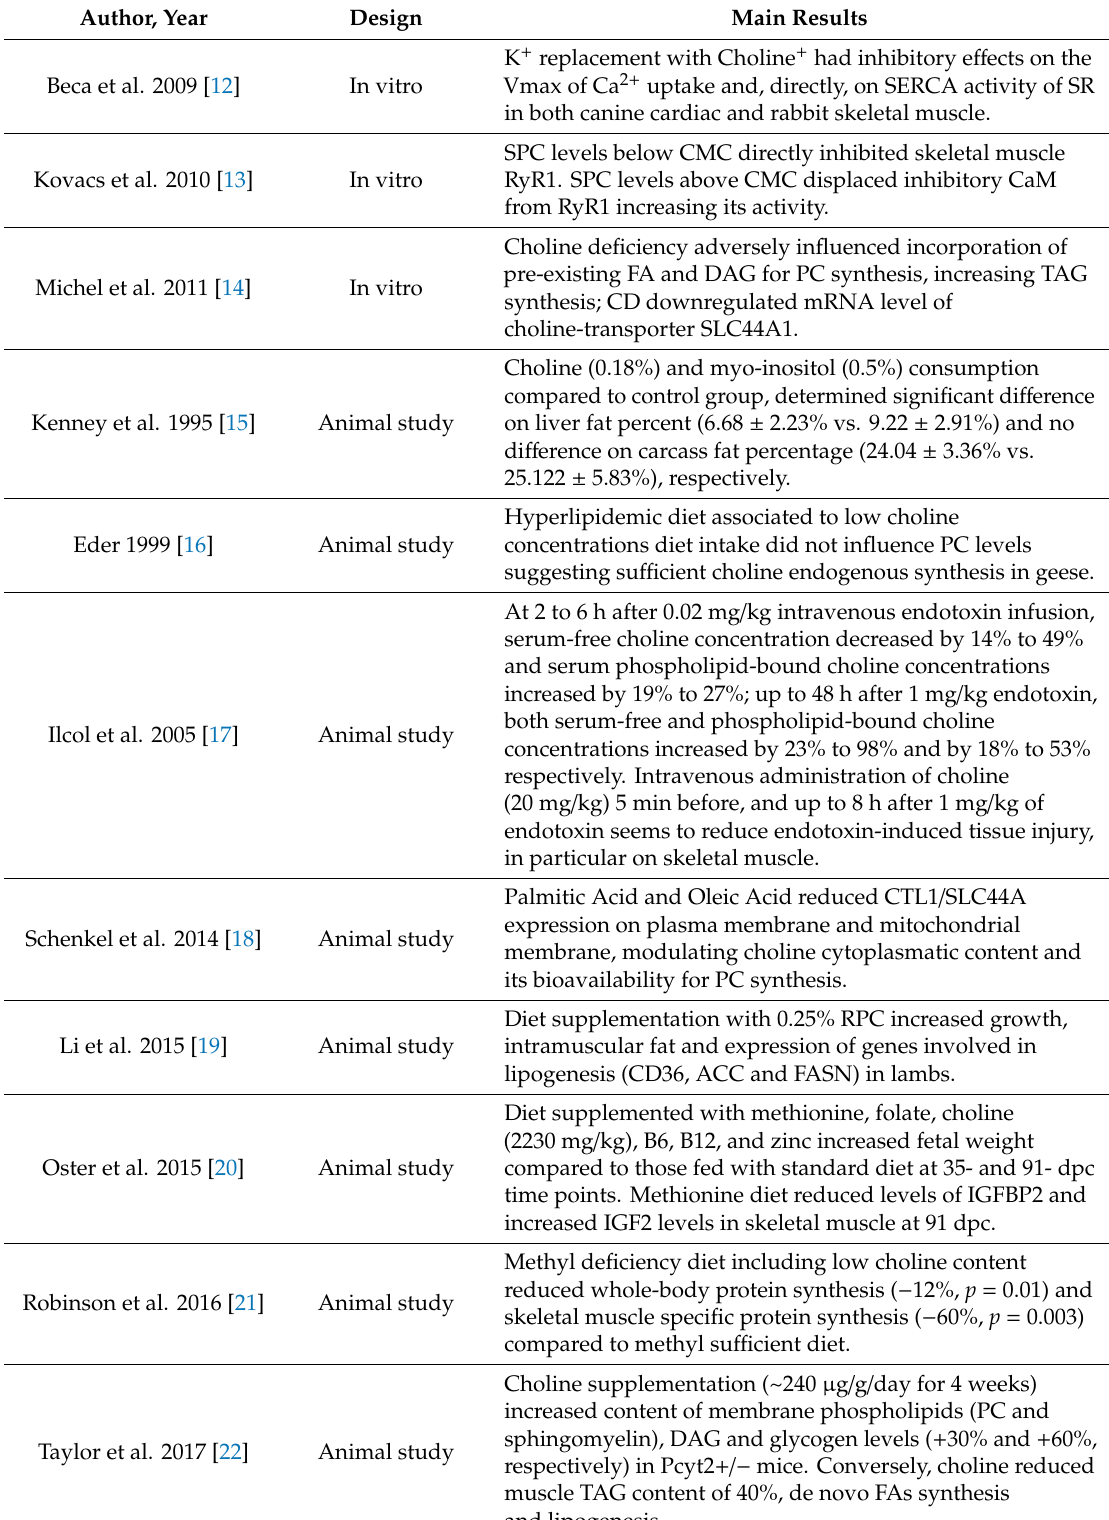
Table 1. Relevant data from each study included in the scoping